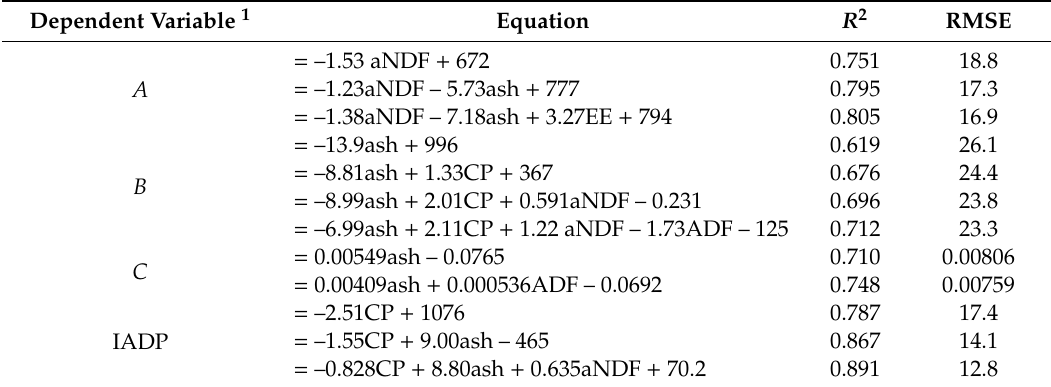
Table 6. Equations to predict the ruminal degradability parameters A , B , (g / kg CP), and C (h − 1 ) of crude protein and intestinally absorbable digestible protein (IADP; g / kg CP) of common vetch